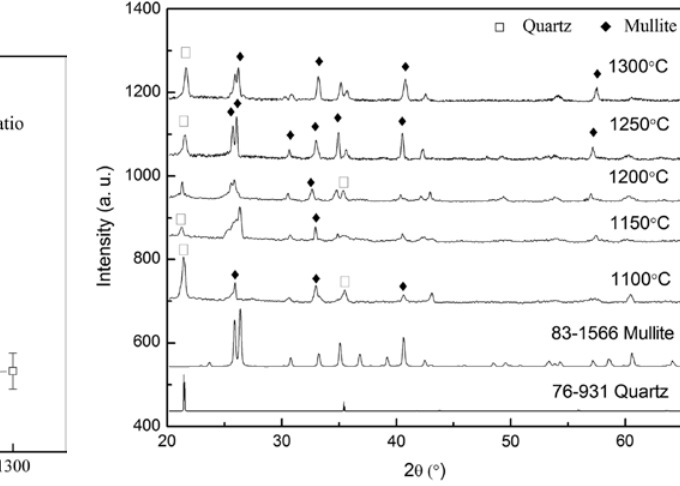
Figure 3: The crush ratio under 52 MPa pressure of the proppants sintered at different temperatures.